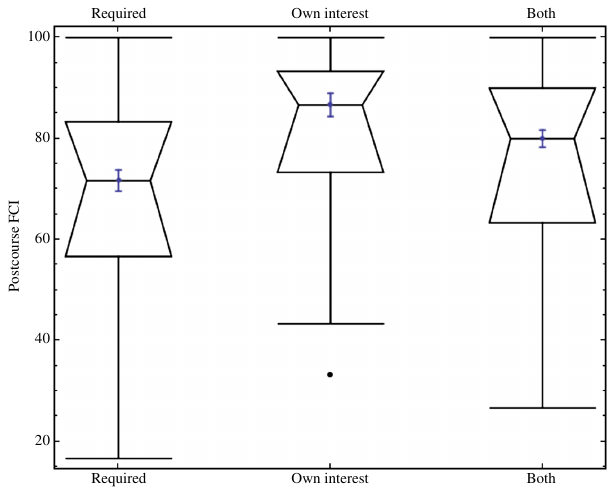
FIG. 4. Boxplots of the postcourse FCI scores for different reasons for taking PHY131.